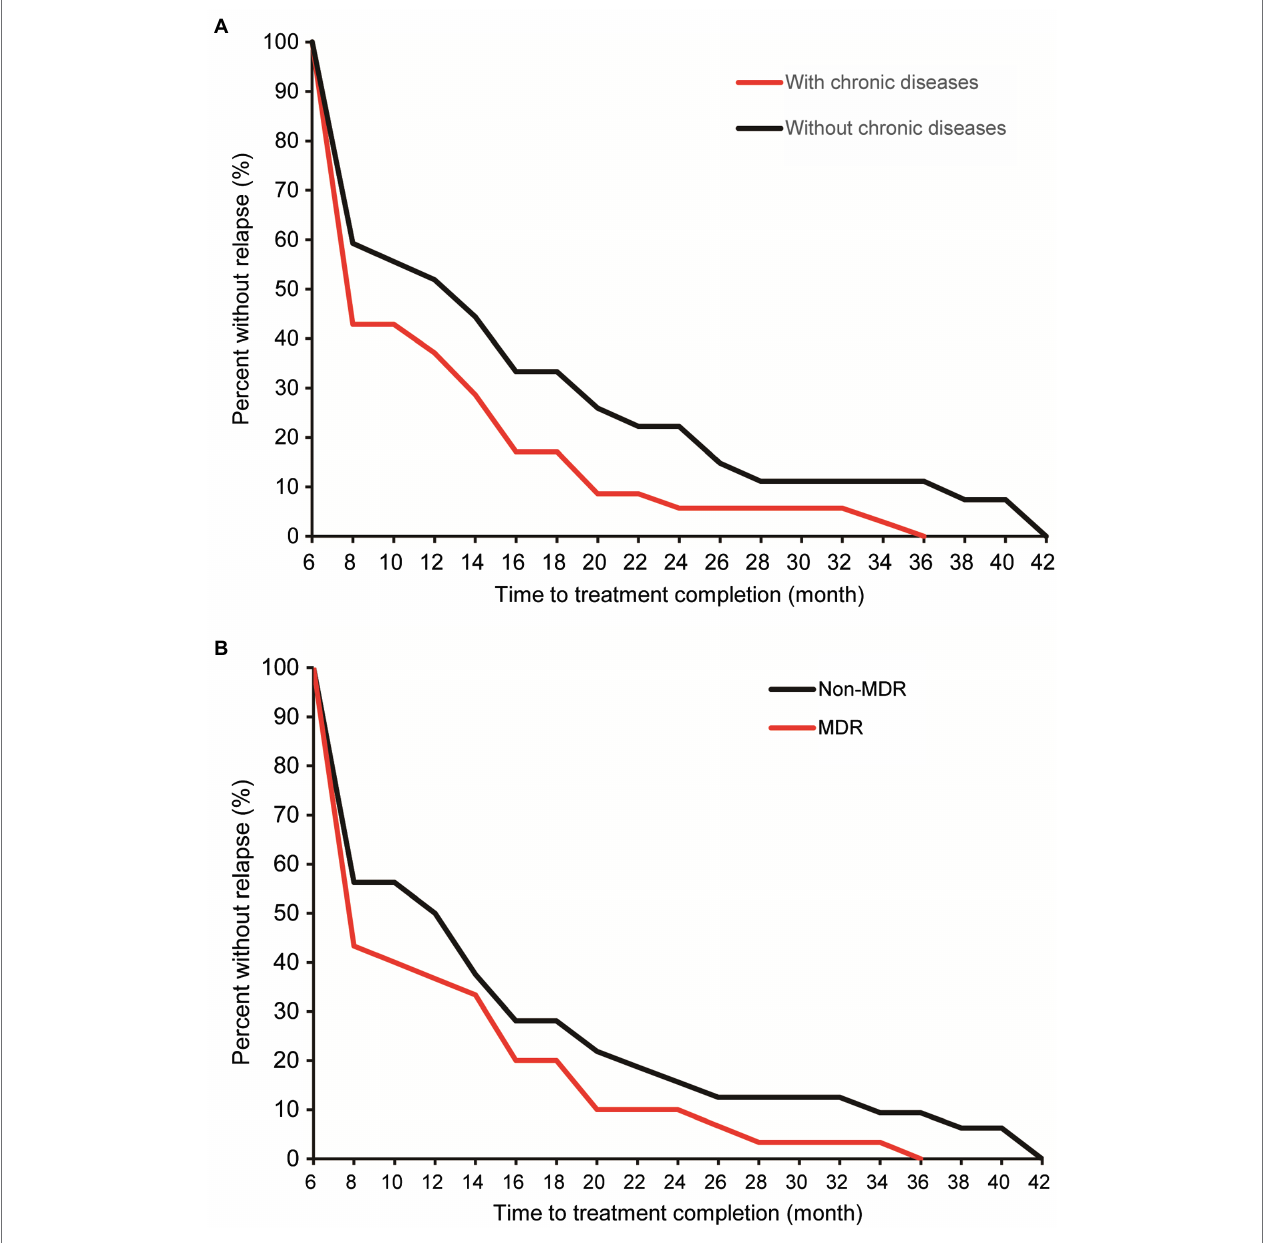
FIGURE 4 | Cumulative percent of confirmed relapse tuberculosis by comorbidity (A) and multidrug-resistant tuberculosis (MDR-TB; B